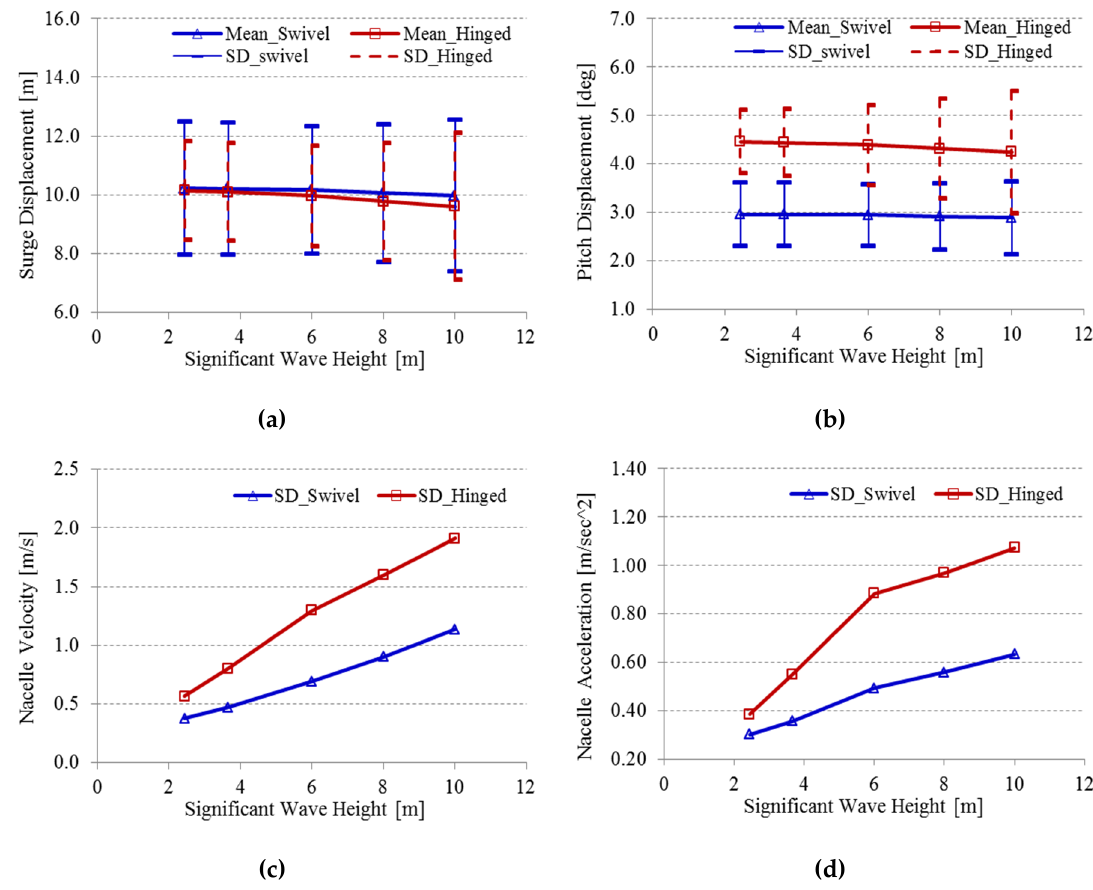
Figure 15. Wave effect on surge/pitch motions and turbine performance: ( a ) Surge motion. ( b ) Pitch motion. ( c ) Nacelle Velocity. ( d ) Nacelle Acceleration. SD: standard deviation.